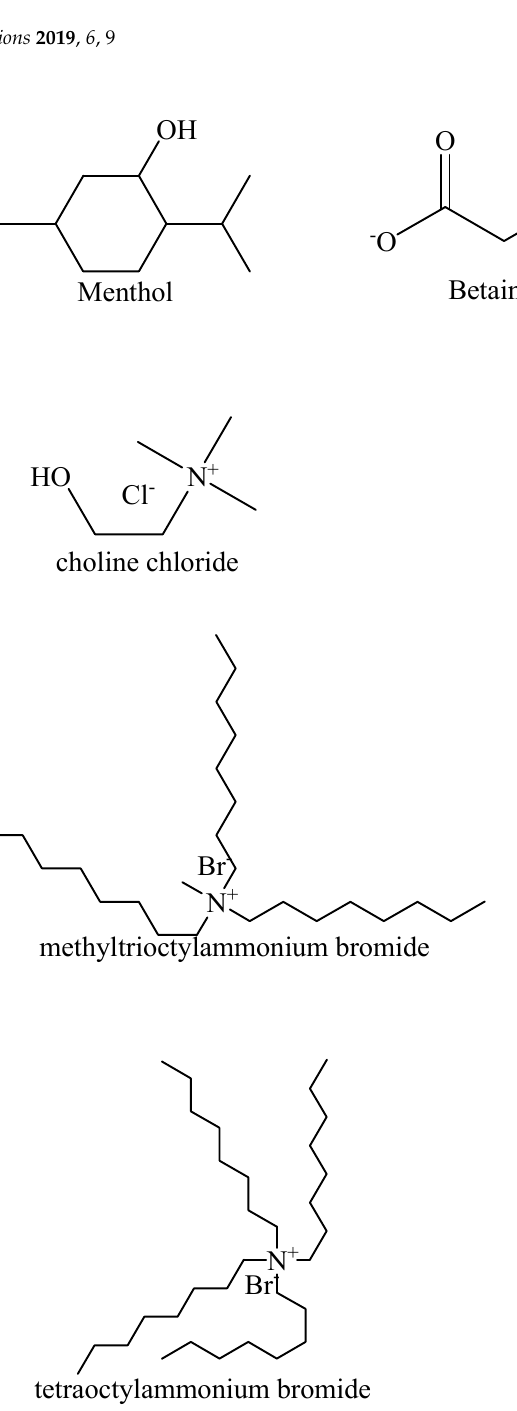
Figure 4. Common HBA used for HDES synthesis.